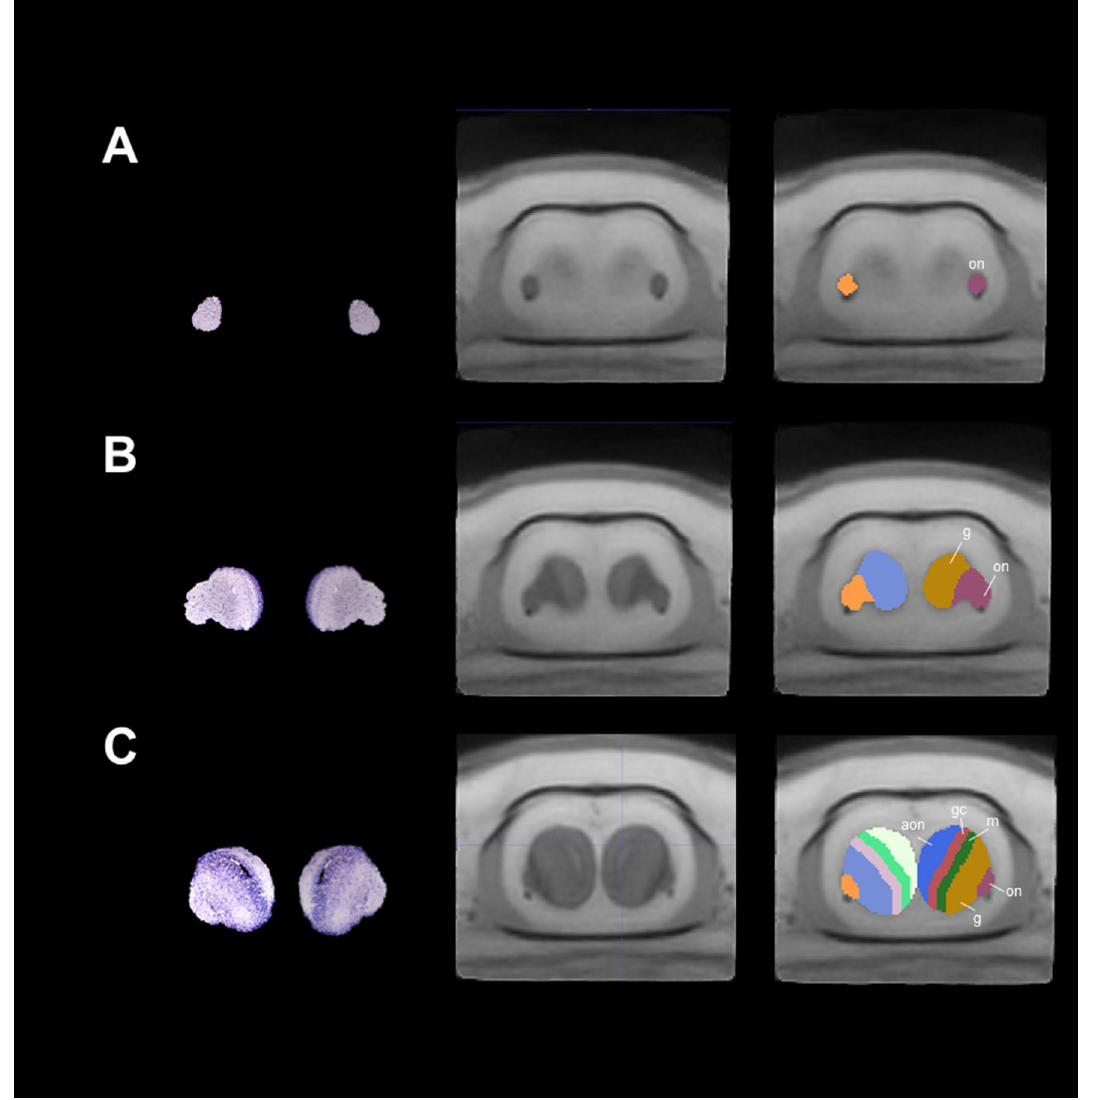
Figure 2. Coronal sections and slices of the olfactory bulb of Ambystoma mexicanum . Columns left, central and right depict the Nissl-staining histological sections; the MRI images and the manual segmentation, respectively created from our template. ( A ) left and right single olfactory nerves; ( B ) the olfactory nerve (on), glomerular layer (g), and ( C ) mitral(m) and glomerular cell layers